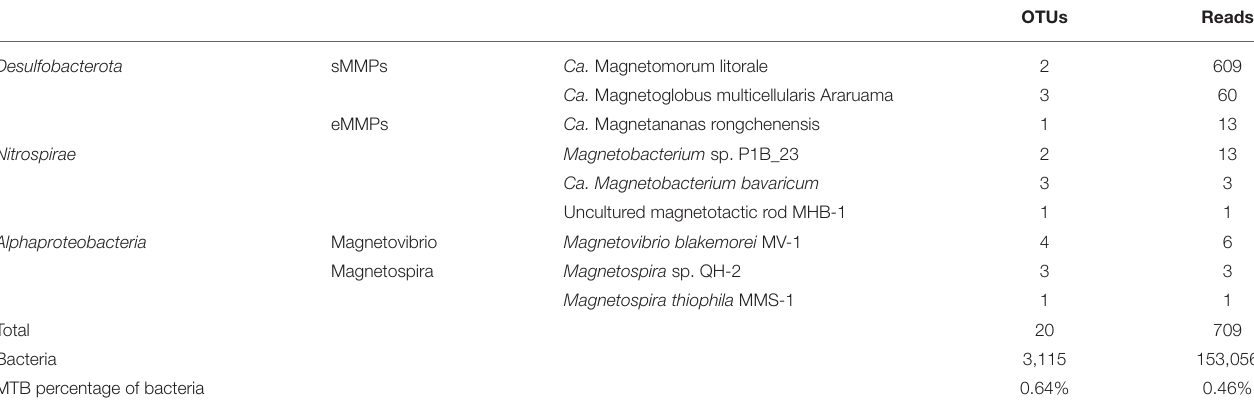
TABLE 1 | Numbers of OTUs and reads corresponding to different species of magnetotactic